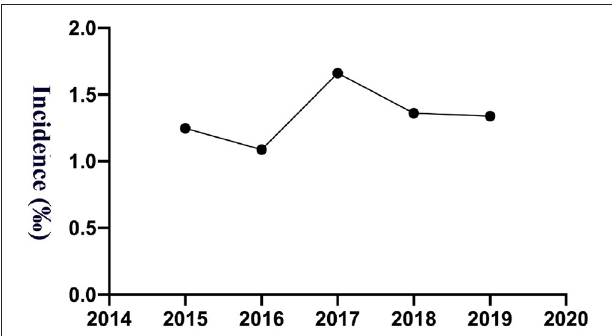
FIGURE 1 | The incidence of transfusion reactions from 2015 to 2019.